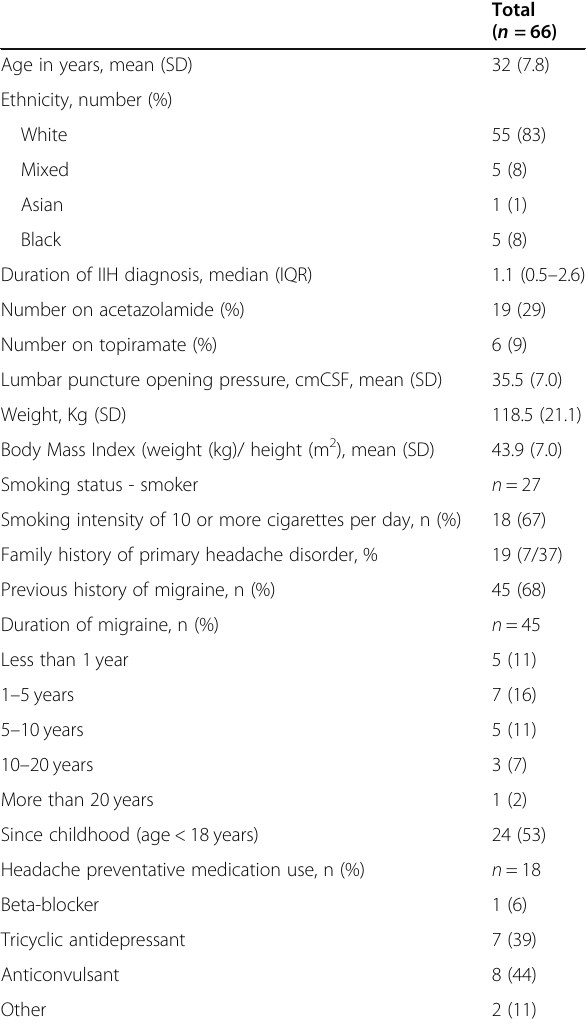
Table 1 Characteristics of the study cohort at